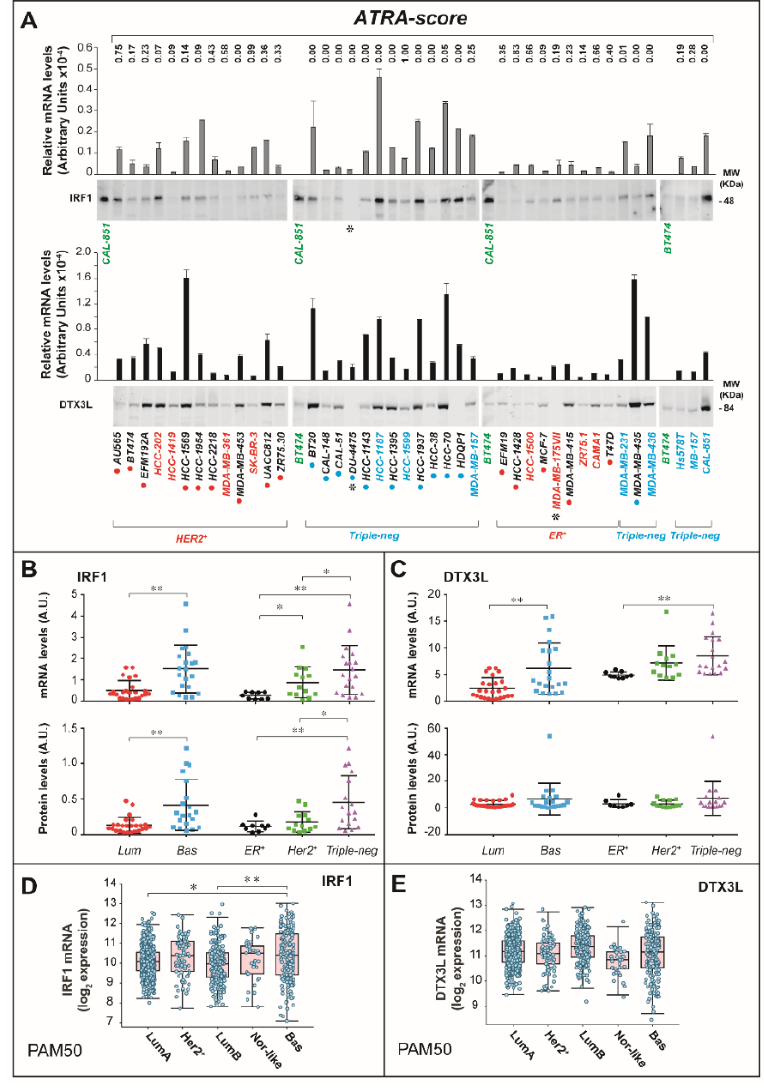
Figure 6. Expression of the IRF1 and DTX3L proteins/mRNAs in breast cancer cell-lines and tissues. ( A ) IRF1 (Interferon-Responsive-Factor-1) and DTX3L (Deltex-E3-Ubiquitin-Ligase-3L) mRNAs were measured by PCR (Polymerase Chain Reaction) in the indicated 41 cell-lines (column graphs). Each value is the mean ± standard deviation (SD) of 3 replicate cultures and the results are normalized for the 18S mRNA. The Western blots illustrate the levels of IRF1 and DTX3L proteins. The 16 cell-lines belonging to our experimental panel are indicated in blue (basal cell-lines) and red (luminal cell-lines). The basal or luminal phenotype of all the other cell-lines is indicated by blue and red dots, respectively. Each well contains an equivalent amount of protein. CAL-851 and BT474 cells (internal loading controls) are marked in green. The asterisk underneath the indicated Western blots marks the cell-lines for which bands are not detectable. The positivity of each cell-line to HER2 ( HER2 + ) or ER ( ER + ) as well as the negativity of each cell line to HER2, ER and PR (progesterone receptor) is indicated by the Triple-neg (Triple-negative) designation. For the whole Western blot figures, please see Supplementary Information. ( B ) and ( C ) The IRF1 as well as DTX3L mRNA and protein levels are compared following clustering of the cell-lines according to the luminal ( Lum ) and basal ( Bas ) phenotype or the presence/absence of the ER (Estrogen Receptor) and HER2 proteins as defined in ( A ). Each point represents a single cell-line. The quantitative protein data were obtained from the densitometric analysis of the Western blots shown in ( A ), following normalization with the internal loading controls. * Significantly different following the Student’s t-test, corrected for multiple testing (Benjamini–Hochberg) ( p < 0.05). ** ( p < 0.01). ( D ) and ( E ) The Box Plots show the IRF1 and DTX3L